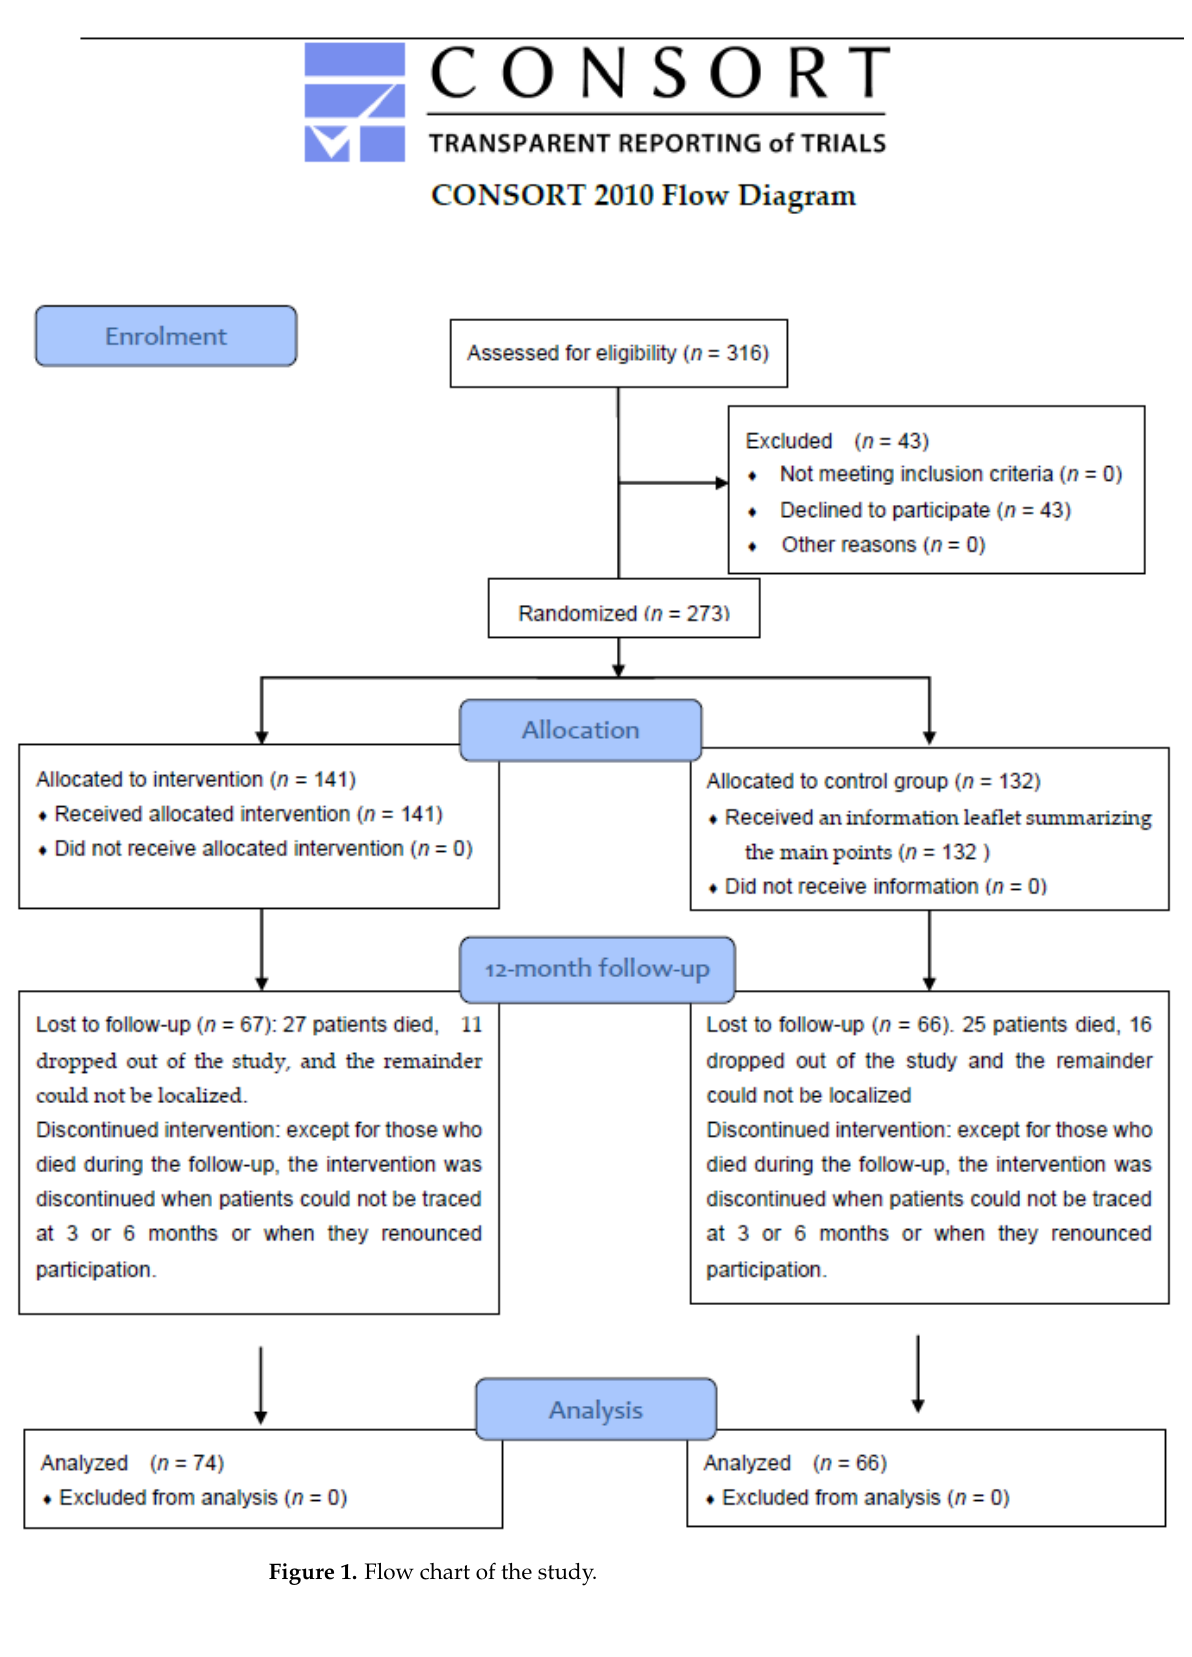
Figure 1. Flow chart of the